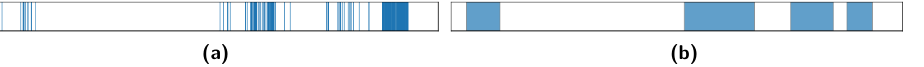
Figure 2: (a): Region identification applied to LTE firmware using a policy of h “NAS” i . (b): Region grouping applied to the result of (a) for R =